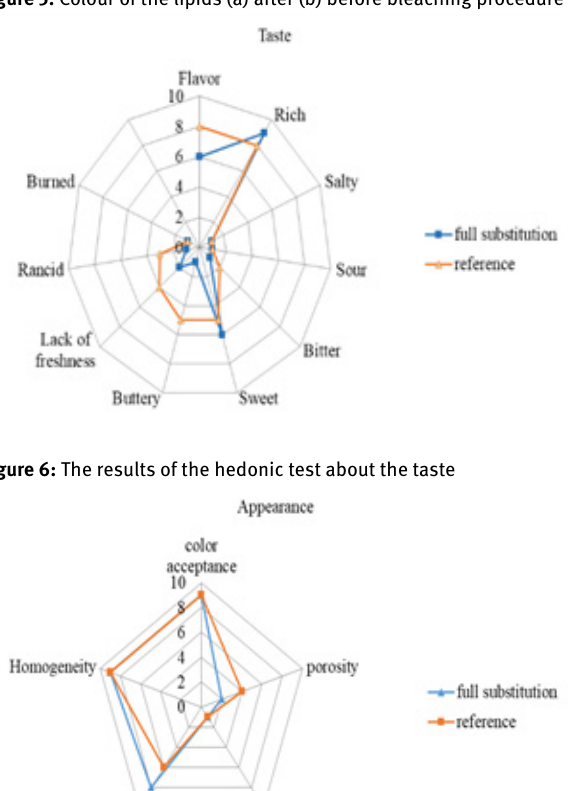
Table 6 : Percentage of extracted protein